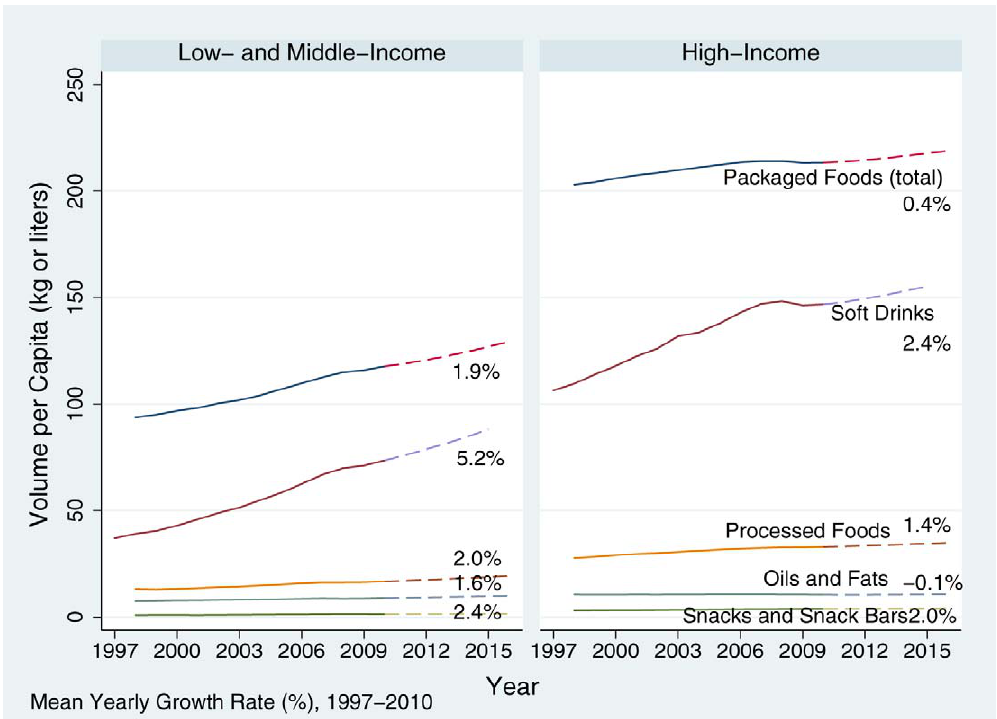
Figure 1. Trends in per capita sales of unhealthy food and beverage commodities, 1997–2010 and projected to 2016. Mean growth rates 1997–2010 are labelled. Data are from the EuroMonitor 2011 dataset. LMICs defined using World Bank criteria as GDP , USD12,500 in the year 2010. Dashed lines are forecast trends between 2011 and 2016.